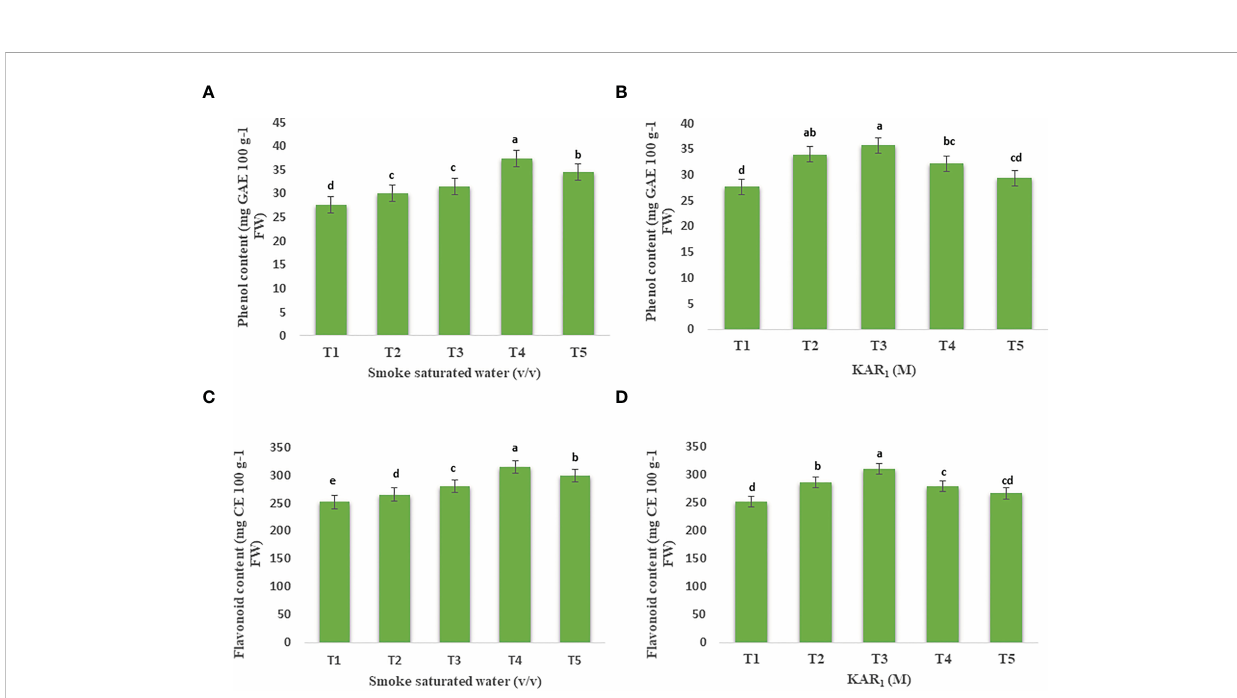
FIGURE 3 Effect of foliar application with smoke-saturated water 1:125, 1:250, 1:500, and 1:1000 v/v) and karrikinolide (10 -9 M, 10 -8 M, 10 -7 M and 10 -6 M)on phenol content (mg GAE 100 g -1 FW) (A, B) and fl avonoid content (mg CE 100 g -1 FW) (C, D) of Mentha arvensis L. Lowercase letters depicts the Duncan. Data are presented as treatments mean ± SE (n = 5). Data followed by the same letters are not signi fi cantly different by Duncan multiple range test at p ≤ 0.05.